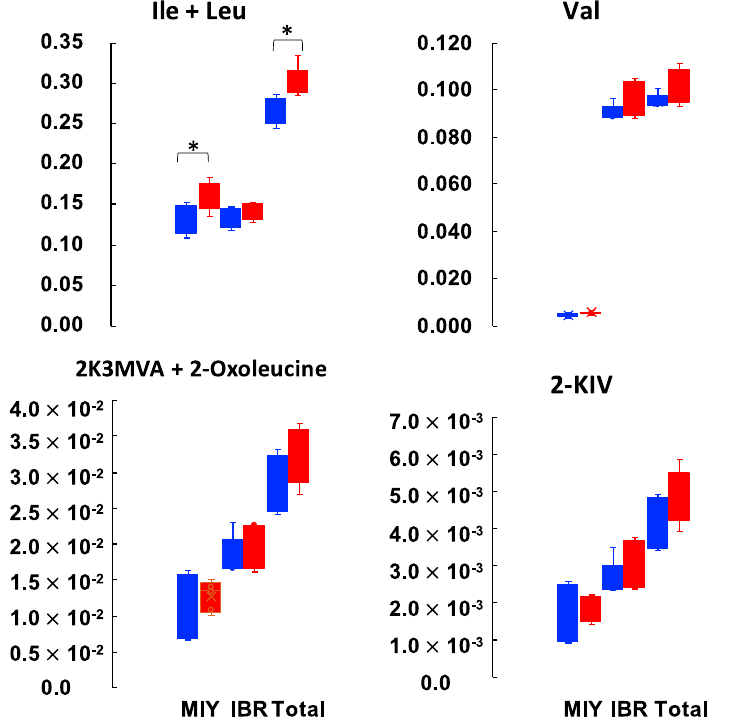
Figure 3. Comparisons of branched-chain amino acids and their degraded metabolites detected from pig plasma samples showing the difference in the intramuscular fat contents at the two stations. Blue and red bars indicate low and high IMF pigs, respectively. Total shows the sum of MIY and IBR. Y -axis indicate the relative area of each metabolites normalized by the internal standard. 3-methyl-2-oxovaleric acid (2K3MVA) and 4-methyl-2-oxovaleric acid (2-oxoleucine), which are the degraded metabolites of Ile and Leu, respectively, could not be separately detected by the capillary electrophoresis-time of flight mass spectrometer (CE-TOFMS). Statistical significance is defined as * (p <